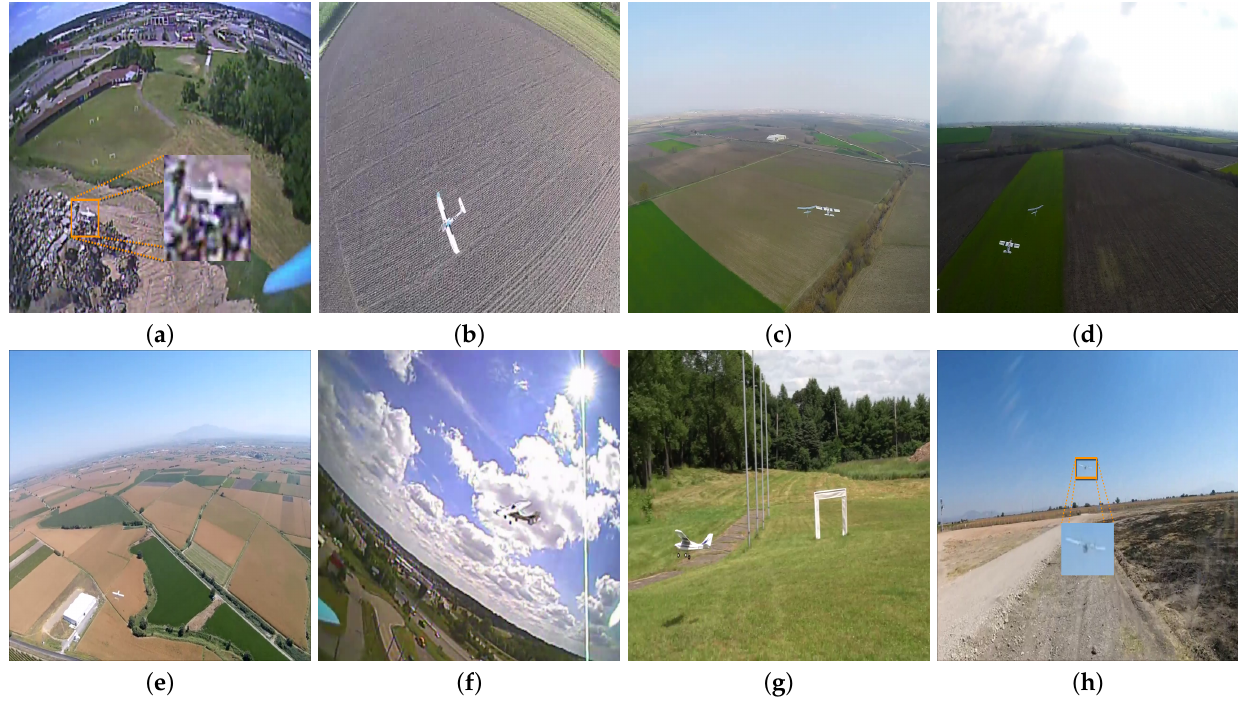
Figure 1. Detecting target or leader UAV in video streams, captured by tracker or follower UAV, deals with several issues including: ( a – f ) large variations in UAV’s visual appearance, viewpoint, dimension of UAVs, illumination, and weather conditions; ( g ) existence of shadows in scene; as well as ( h ) low contrast between UAV and